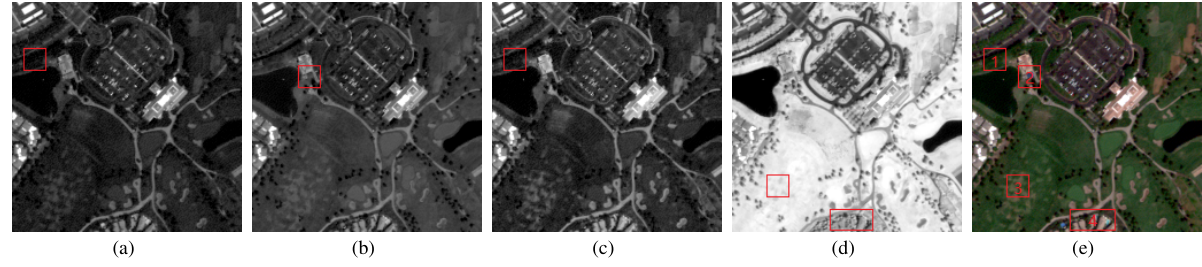
Figure 2. An example of spatial difference between different bands of the MS image. From (a) to (d) are the blue band, the green band, the red band and the near-infared band, respectively. (e) is the true color MS image. Some typical regions are marked with a red box.